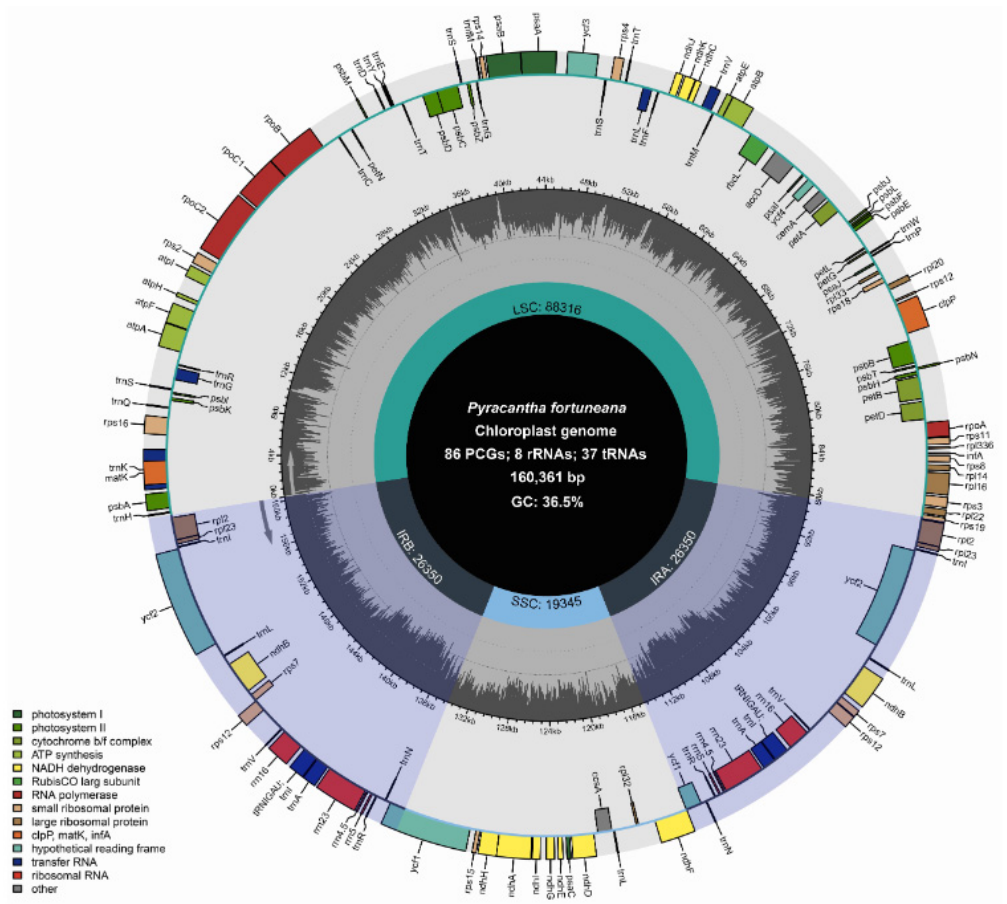
Figure 2. The circular chloroplast genome map of P. fortuneana (red). The genes drawn inside the circle are transcribed counterclockwise while those outside are transcribed clockwise. Different functional genes are differently colored on the outer circle. The dashed darker gray area in the inner circle denotes GC content, and the lighter gray area corresponds to AT content. Table 1. The basic characteristics of five Pyracantha chloroplast genomes.